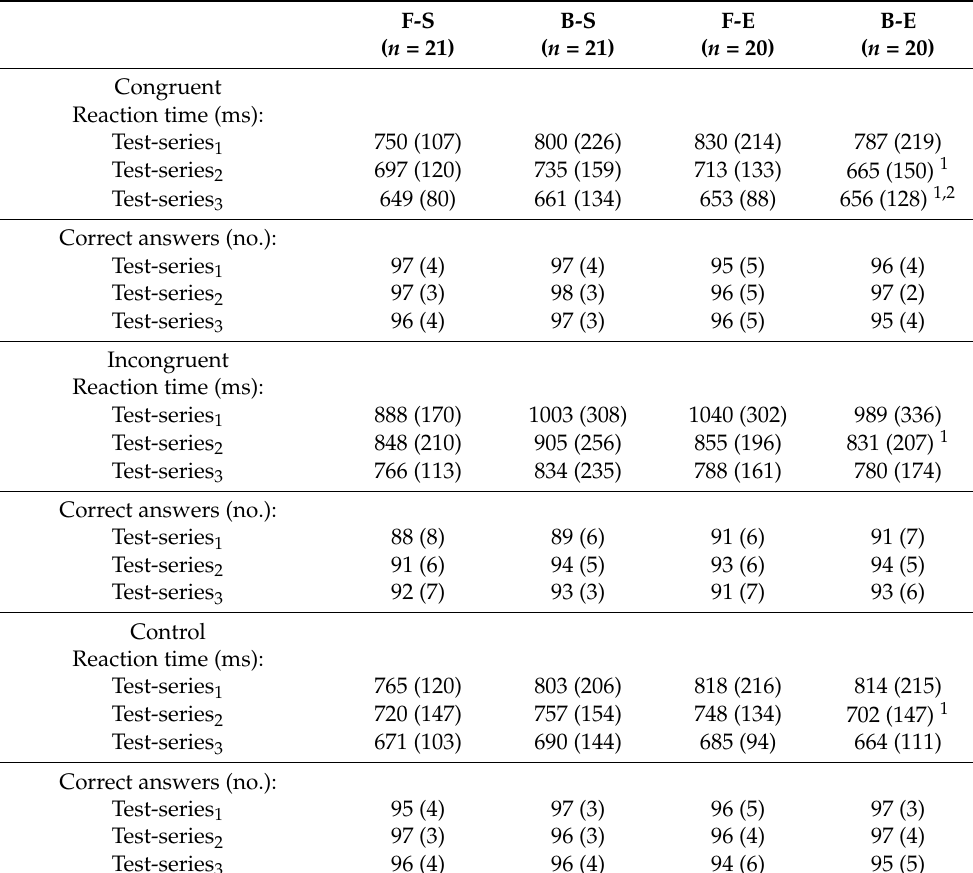
Table 2. Reaction times and number of correct answers for congruent, incongruent and control trials in the Stroop Color-Word